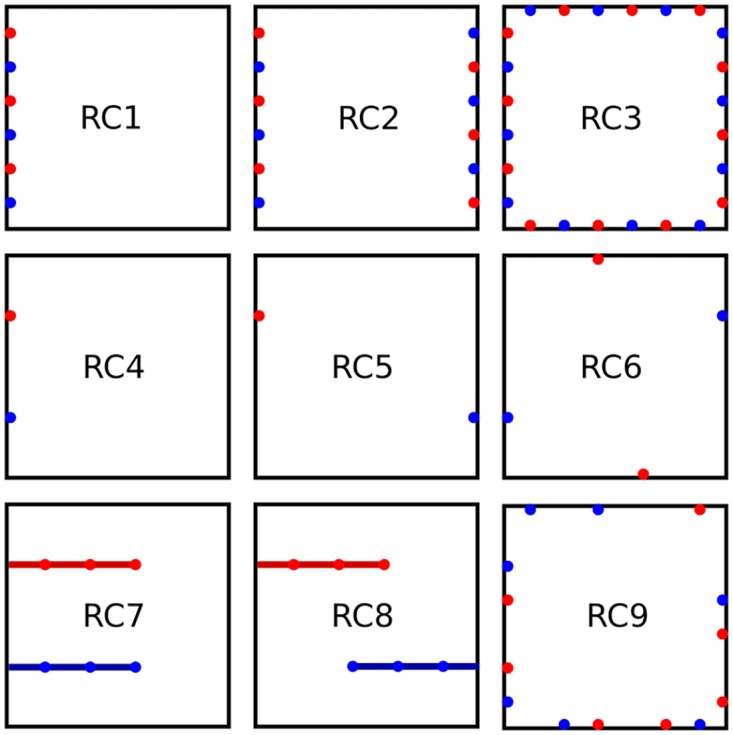
Illustration of vascular tree configurations.Schematic views from above on simulation cubes indicate vascular tree root locations for configurations denoted RC1 to RC9. In RC1 to RC3 boundary sites are occupied in alternating order either with arterial or venous nodes. In RC1 only one face of the simulation cube is used, in RC2 two opposing sides are used and in RC3 four faces are used. In RC4, RC5 and RC6 we place nodes at 33% and 66% of the length of the cube faces diagonals on the diagonals. As before, one, two and four faces are used, where in total only two (RC4, RC5) and four nodes (RC6) are placed. In RC7 and RC8 we first create fixed parent vessels protruding along the x-axis to 60% of the cube length into the interior. On each site occupied by these parent vessels a regular root node is created for further growth. Flow boundary conditions are specified at the actual inlets and outlets at the cube boundaries. In RC9 each boundary site of the lattice is occupied with a root node with probability proot. Before a network is created, proot is drawn equally distributed between 0 and 1, however a configuration is only accepted if there is at least one arterial and one venous node.